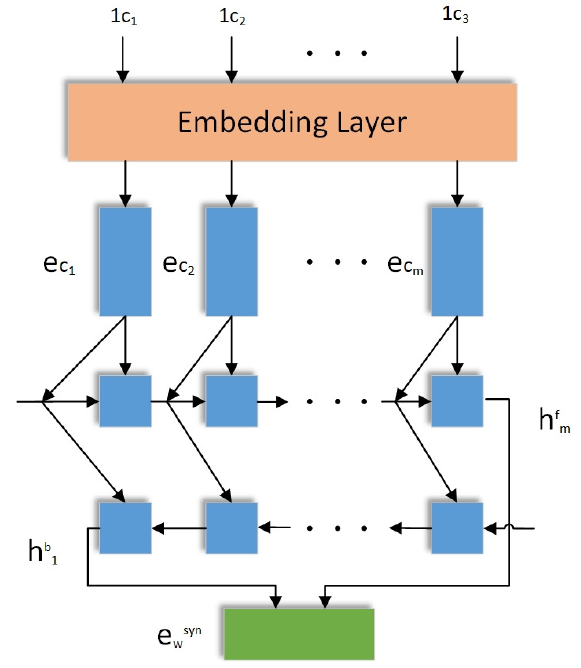
Figure 2. BiGRU network structure for mining contextual features.